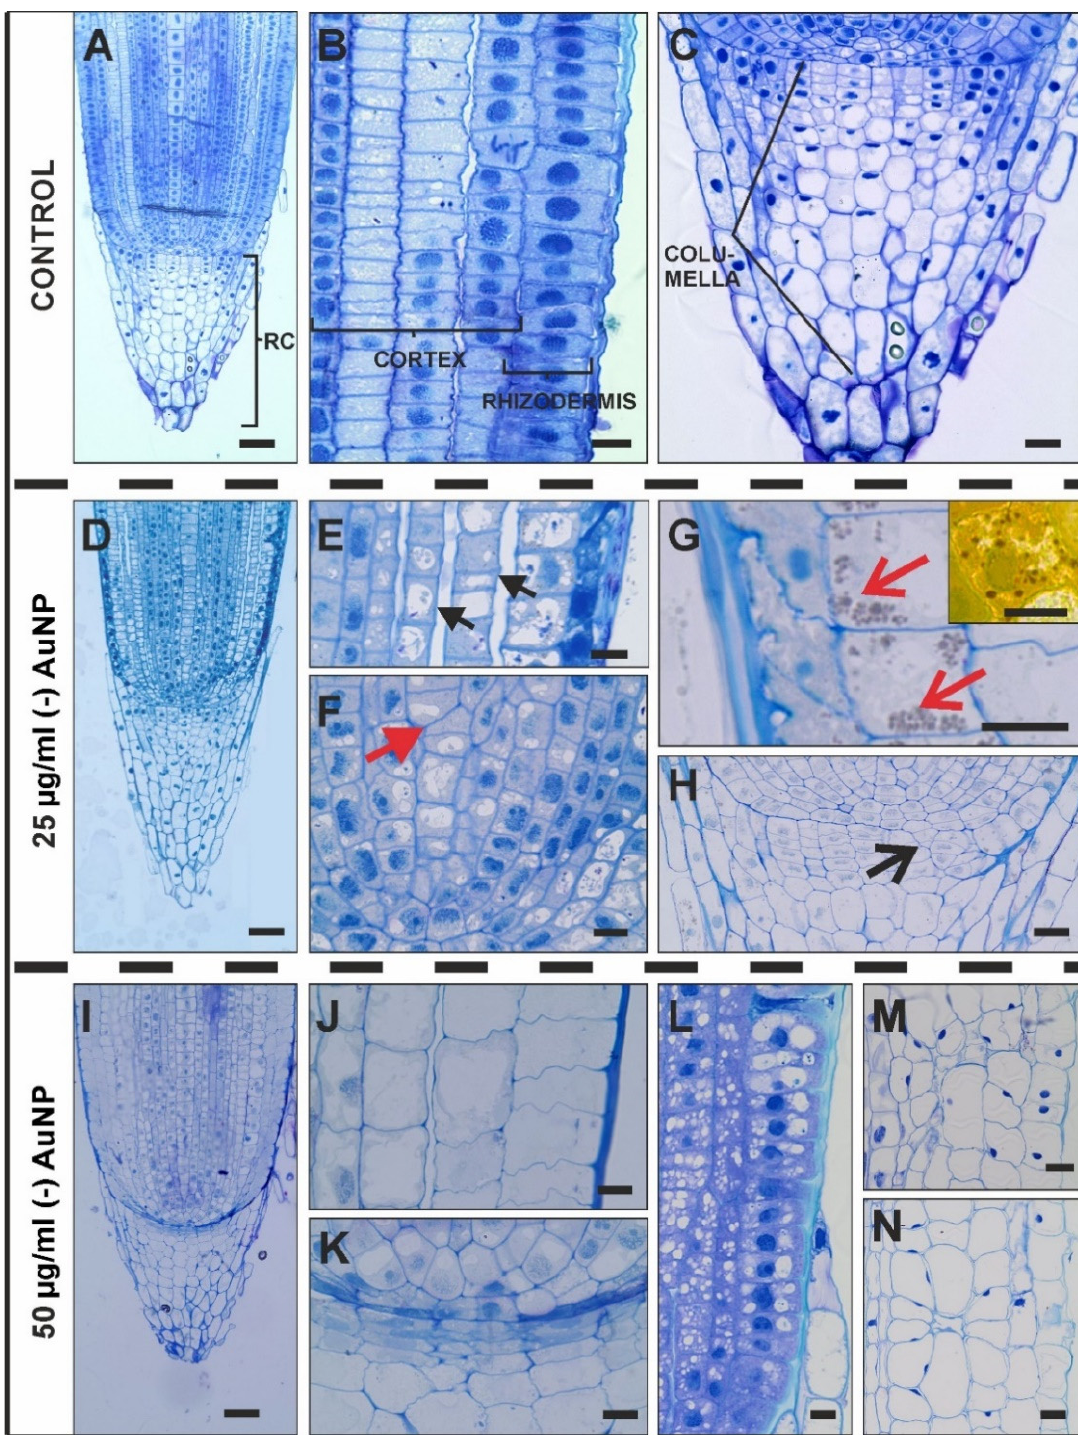
Figure 2. Longitudinal section through the barley RA (root apex) from the control roots ( A – C ), the roots growing in the 25 µ g/mL (-) AuNP ( D – H ) or 50 µ g/mL (-) AuNP ( I – N ) conditions. Black arrows—large intercellular spaces between the cortical cells ( E ); red arrow—atypical division of the central metaxylem vessel in the distal meristem ( F ); red open arrows—the amyloplast in the outer cortical cells ( G ); black open arrow—rearrangement of the proximal meristem organisation ( H ). TBO staining (apart from the G inset—Lugol’s staining that indicates the presence of amyloplasts in the cortical cell). Scale bars: ( A , D , I ) = 50 μ m; ( B , C , H , L , M , N ) = 20 μ m; ( E , F , G , G Inset , J , K ) = 10 μ m.